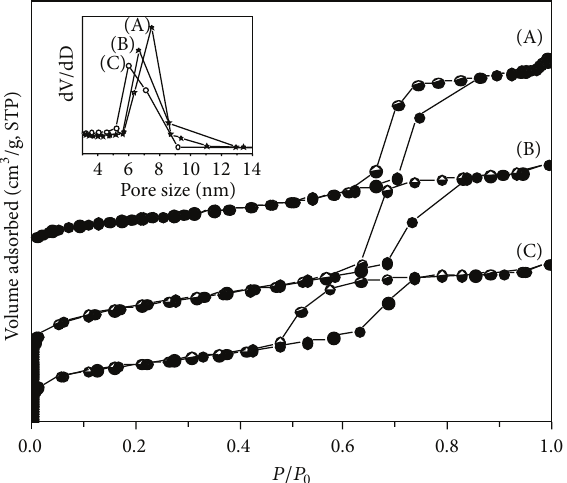
Figure 5: Diffuse reflectance UV-Vis spectra of TiO 2 -SBA-15 (a) and N-TiO 2 -SBA-15